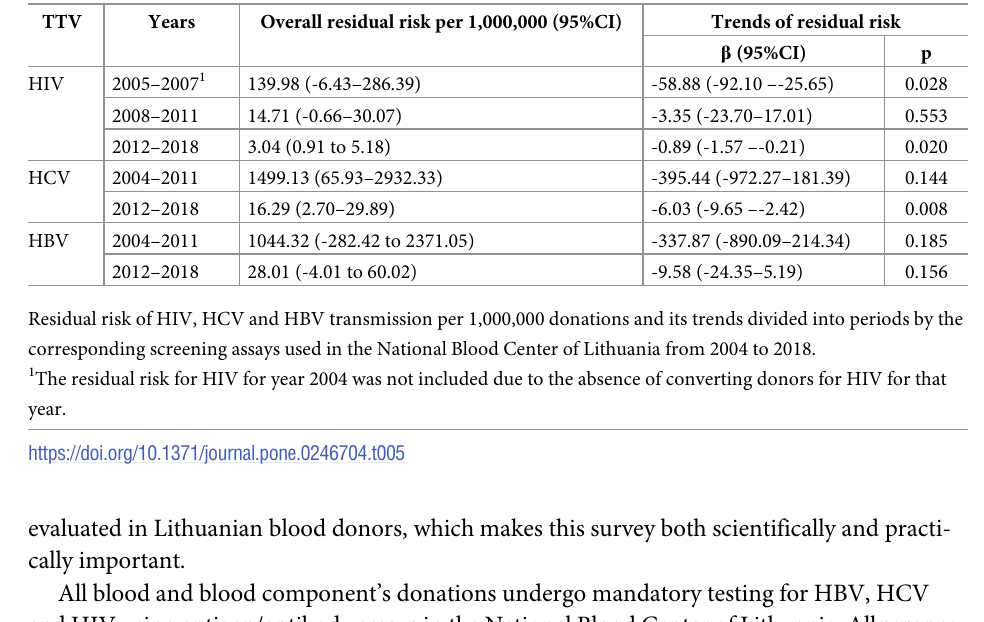
Table 5. HIV, HCV and HBV transmission residual risk and residual risk trends by period of screening